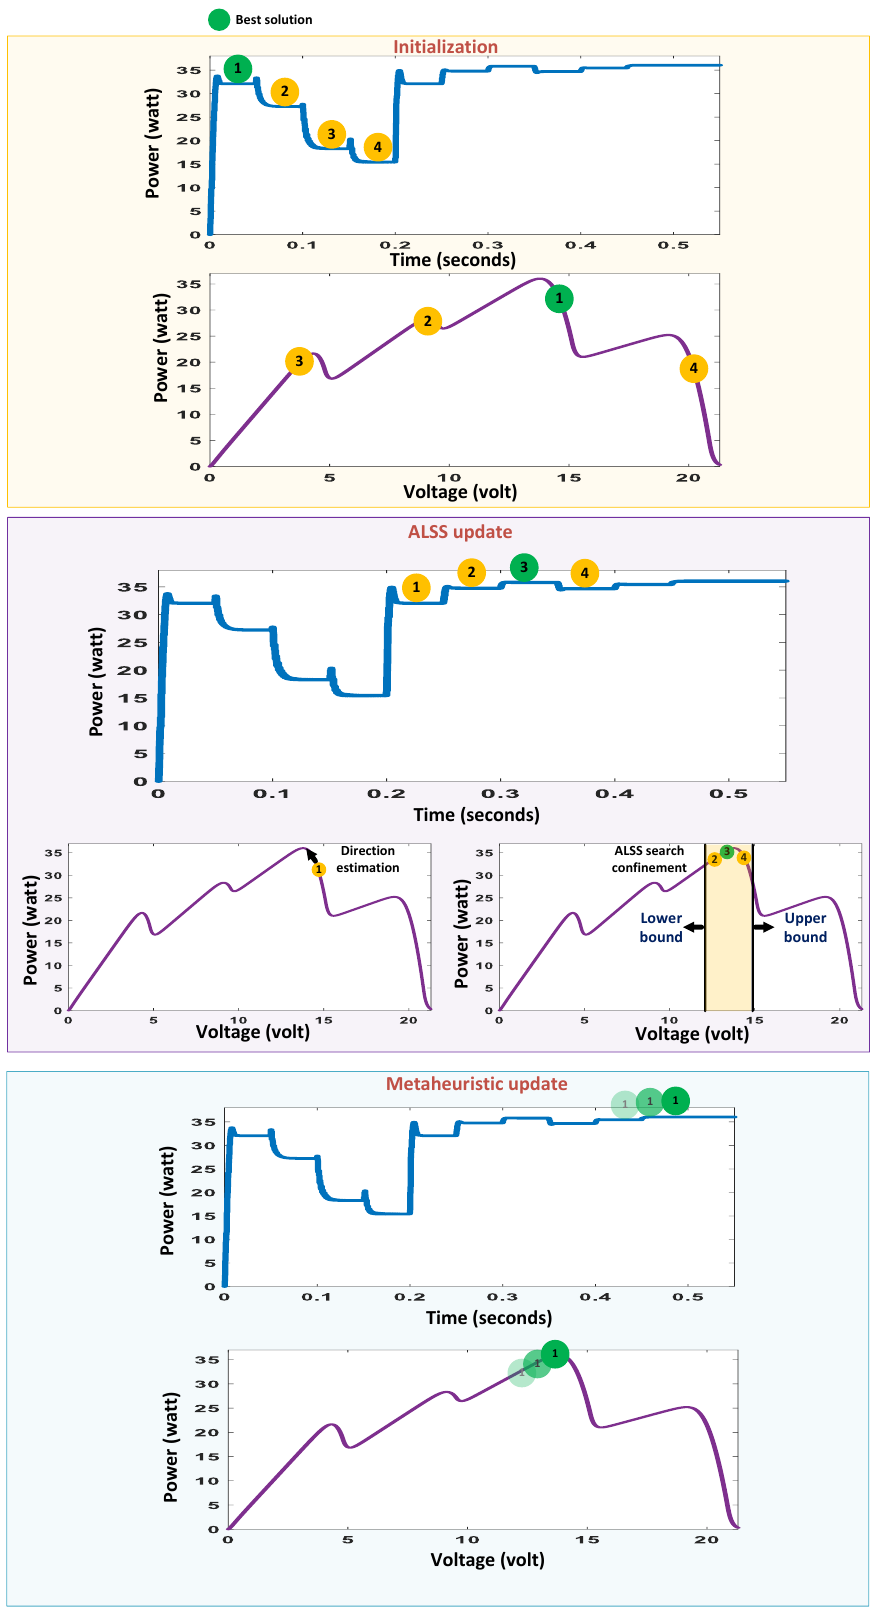
Figure 4. Running example of the ALSS applied to a metaheuristic algorithm. Consists of three phases: the initialization, the ALSS update, and the metaheuristic